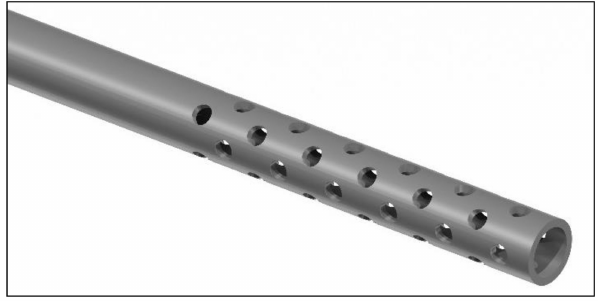
Figure 2. The solid model of the consumable part of the EAPA